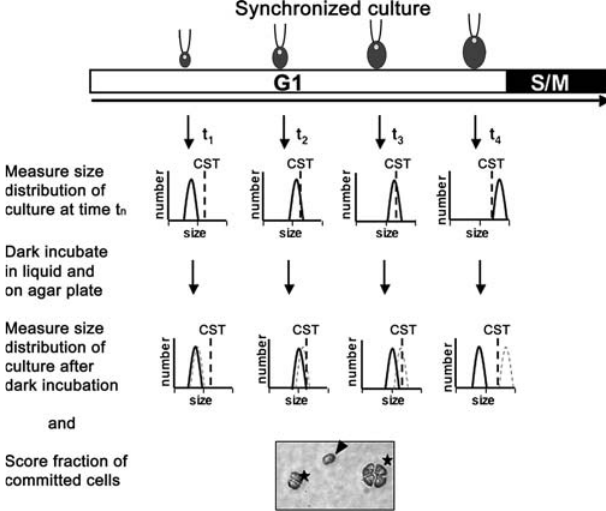
Figure 3. Schematic Illustration of Commitment Size Threshold Assay The light/dark phases of synchronized cultures are indicated by the white and black bar on top. Aliquots of G1 cells are removed at different times (t 1 , t 2 , t 3 , t 4 ), for size measurements (schematized in top row), and for dark-incubation in liquid and on plates. The dashed vertical line labeled CST represents a potential C ommitment S ize T hreshold. After dark-incubation for 18 to 24 h in liquid, the daughter cell size distribution is measured (schematized in lower set of size distribution curves). The light-colored dashed curve represents the size distribution prior to the dark shift, and the dark solid line represents the cell size distribution after dark shifting and cell division. The aliquot of cells that was incubated on plates in the dark was scored microscopically to determine the fraction of committed cells in the population. The arrowhead in the picture inset indicates a cell that was not committed, and the stars indicate cells that were committed and divided either once or twice to produce two and four daughters, respectively. The CST is empirically determined by finding a size threshold value that best explains the behavior of the cells with respect to the fraction that were committed in each sample. The reliability of this value is reflected in the standard error (see Table 1). DOI: